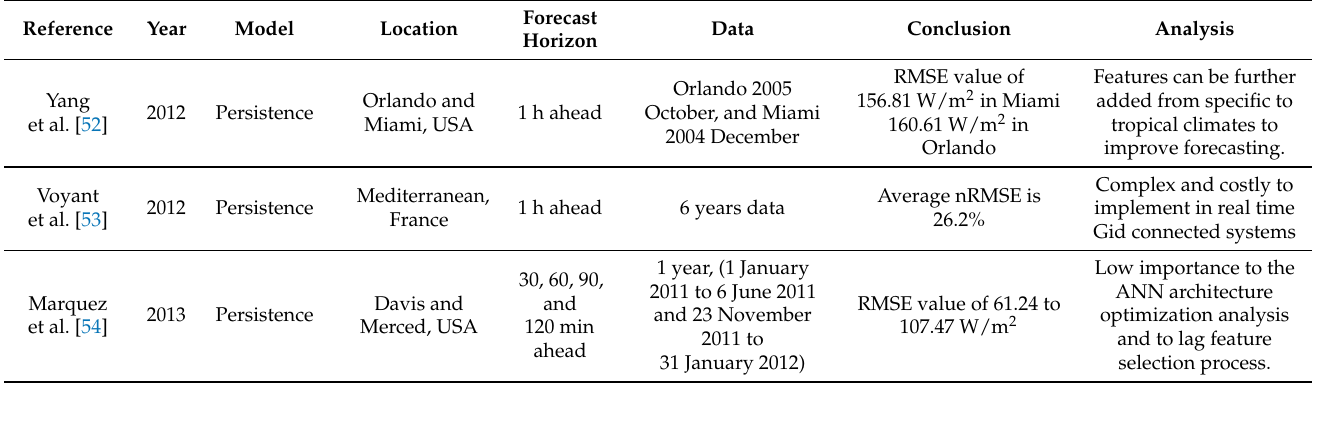
Table 3. Summary of Basic models.